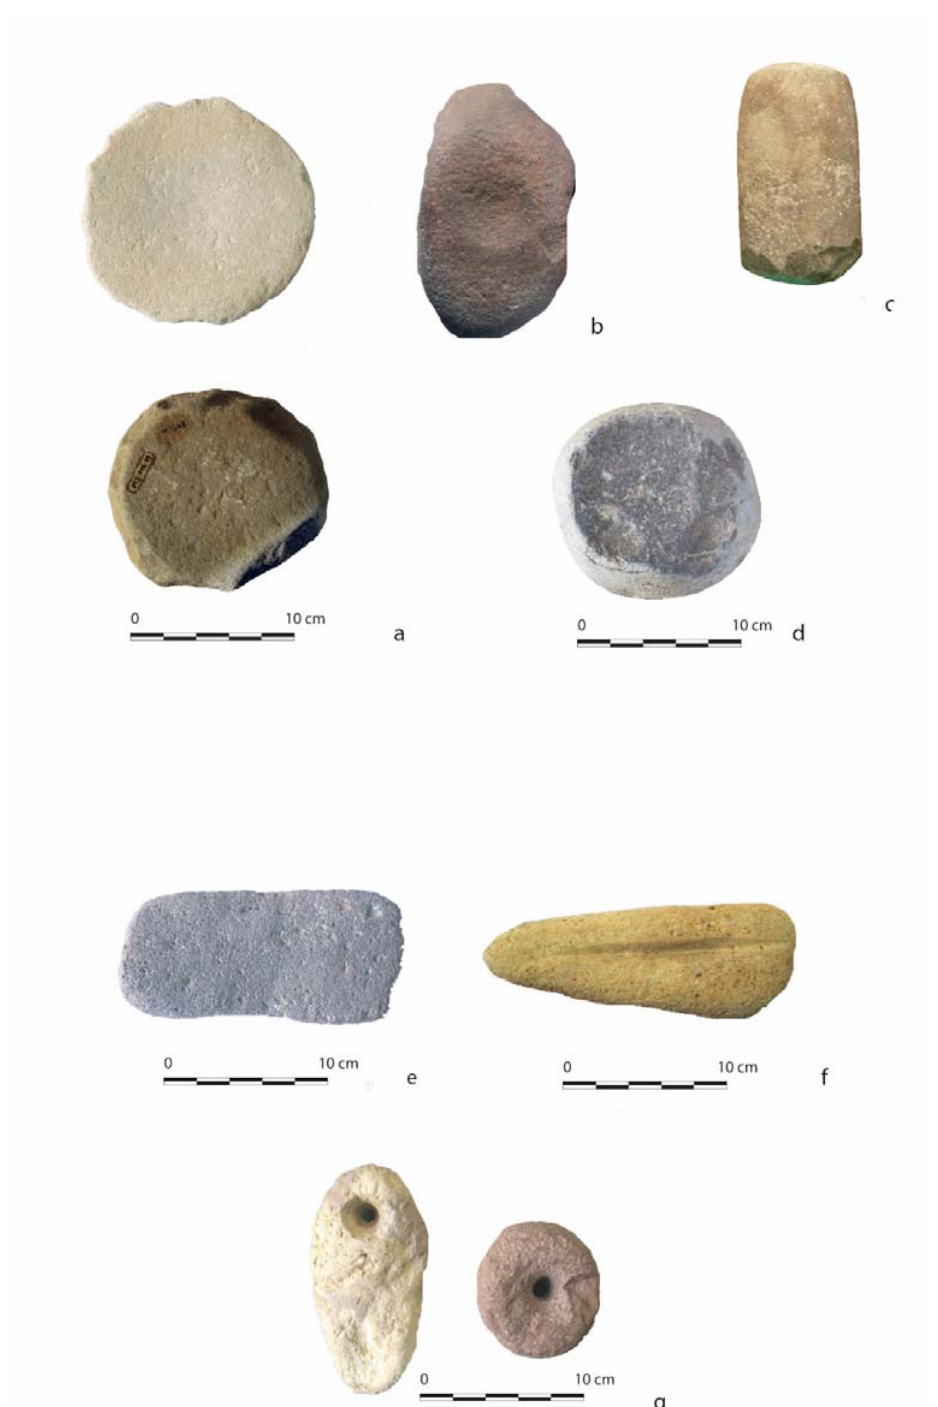
Figure 5. Late Neolithic percussing and abrading tool types from the middle Kura valley a. Circular grinding slab of “Imiris” type; b. crushing tool (Shulaveris gora); c. Pestle (Mentesh tepe); d. Hammerstone (Mentesh tepe); e. abrader-pestle in pumice (Shulaveris gora); f. polisher (Imiris gora); g. perforated items (Imiris gora) (photographs by C.